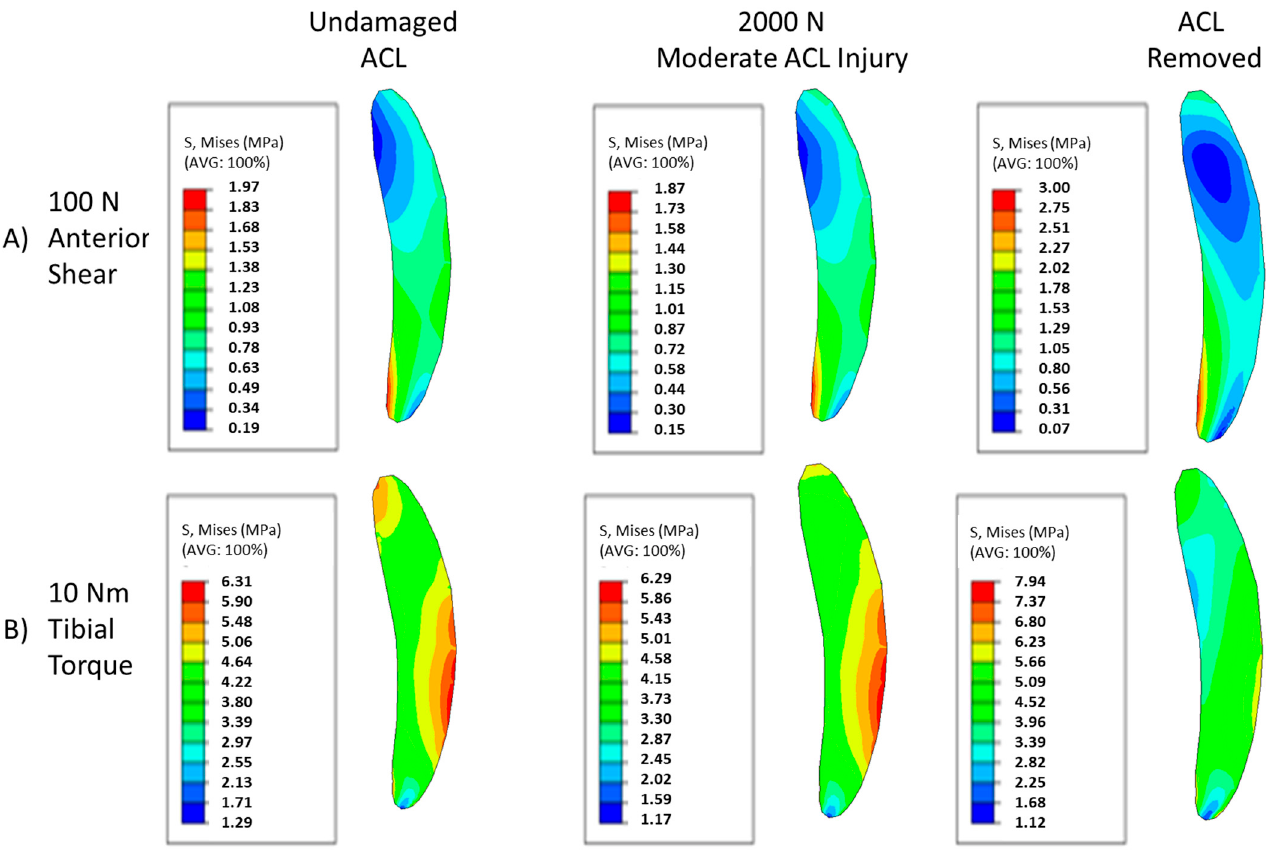
Figure 3. Contour plots of MCL mid-substance von Mises stress (Pa). ( A ) Contour results for at 100 N anterior shear force on the tibia for undamaged, moderate injury, and complete ACL destruction. ( B ) Contour results for at 10 Nm tibial torque on the tibia for undamaged, moderate injury, and complete ACL destruction.